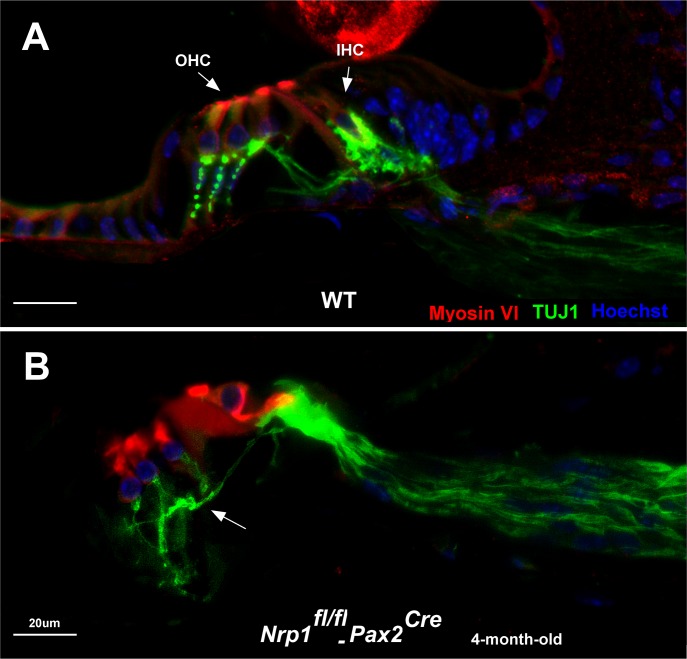
Aberrant innervation of OHCs in Nrp1fl/fl;Pax2Cre mice at 4 months of age.TUJ1 immunostaining of the mid-modiolar cross-section of cochleae of 4-month-old WT (A) and Nrp1fl/fl;Pax2Cre mice reveals disorganized innervation of the OHCs in Nrp1-CKO compared to WT controls. Arrow shows abnormal innervation of the OHCs (B). Scale bar = 20 μm.